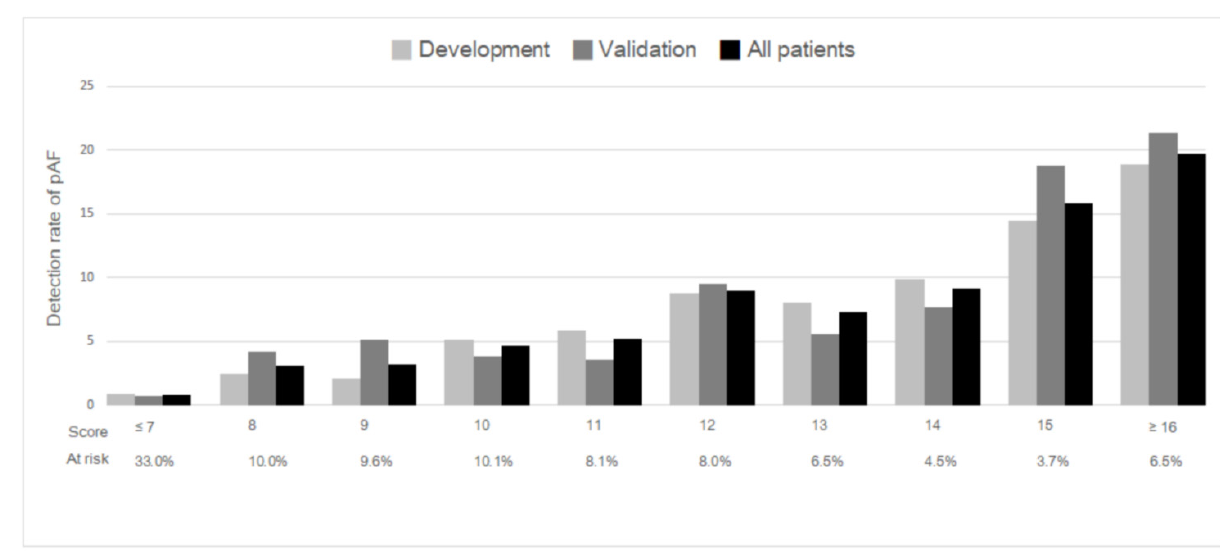
Figure 1. Rates of pAF detection across risk scores. “At-risk” is defined as the proportion of all patients with the respective score. Abbreviations: pAF, paroxysmal atrial fibrillation. Table 3. Risk categories and corresponding detection rate of paroxysmal atrial Table 2. Logistic regression model for diagnosis of paroxysmal atrial fibrillation.